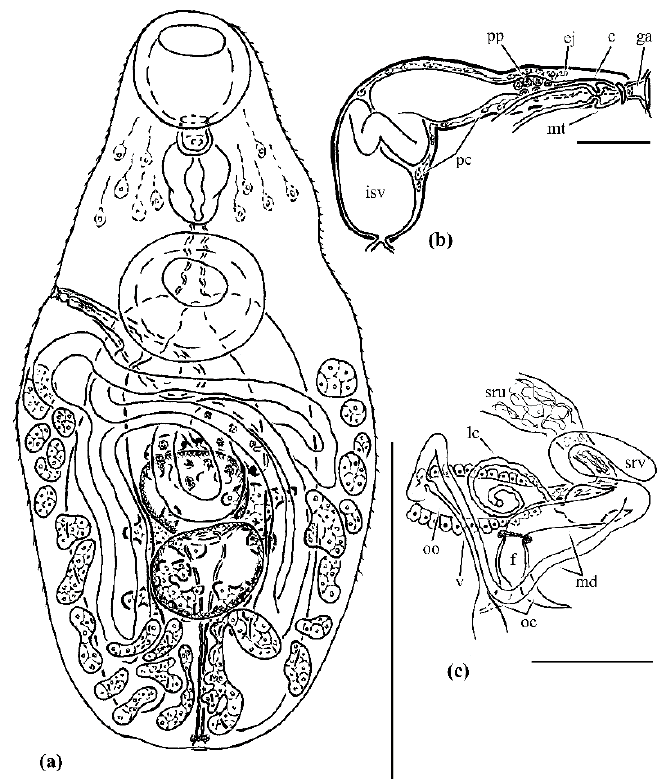
Figure 3. Anarhichotrema ochotense from intestine of Anarhichas orientalis , the Sea of Okhotsk: ( a ) whole mount, ventral view; ( b ), terminal genitalia, ventral view; ( c ), ovarian complex, dorsal view. Abbreviations: c, invaginated cirrus; ej, ejaculatory duct; f, fertilization chamber; ga, common genital atrium; isv, internal seminal vesicle; lc, Laurer’s canal; md, middle part of oviduct; mt, metraterm; oc, ovicapt; oo, oötype with Mehlis’ gland cells; pc, prostatic cells; pp, pars prostatica; src, canalicular seminal receptacle; sru, uterine seminal receptacle; v, vitelline reservoir. Scale bars: a = 500 μ m, b, c = 50 μ m.